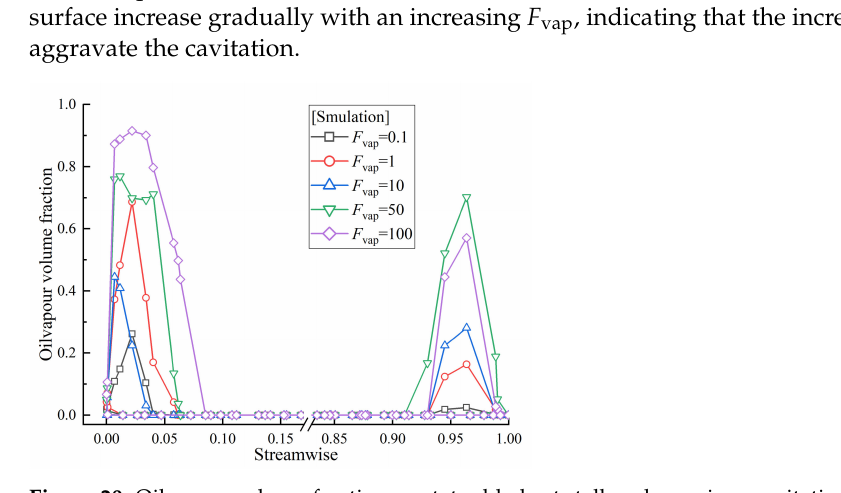
Figure 20. Oil vapor volume fraction on stator blade at stall under various cavitation vaporization co-